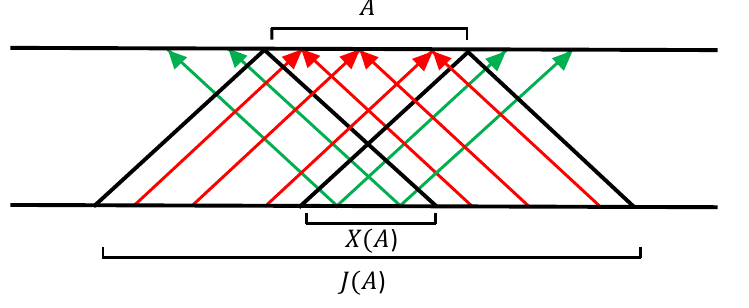
Figure 13 . All operators from the region X ( A ) propagate to ¯ A . Any operator non-trivial in J ( A ) − X ( A ) has a part that propagates to A